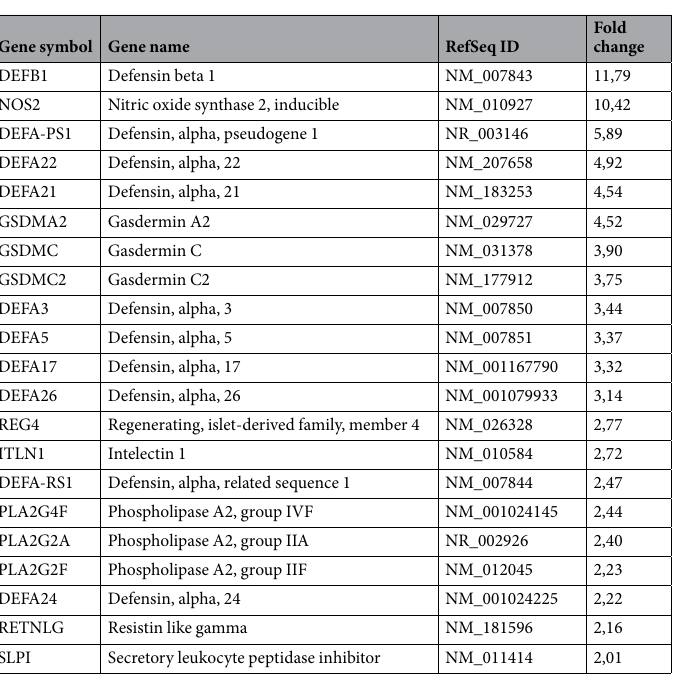
Table 2. List of upregulated antimicrobial genes as identified by RNA-seq in C57BL/6 WT infected mice versus C57BL/6 WT uninfected control